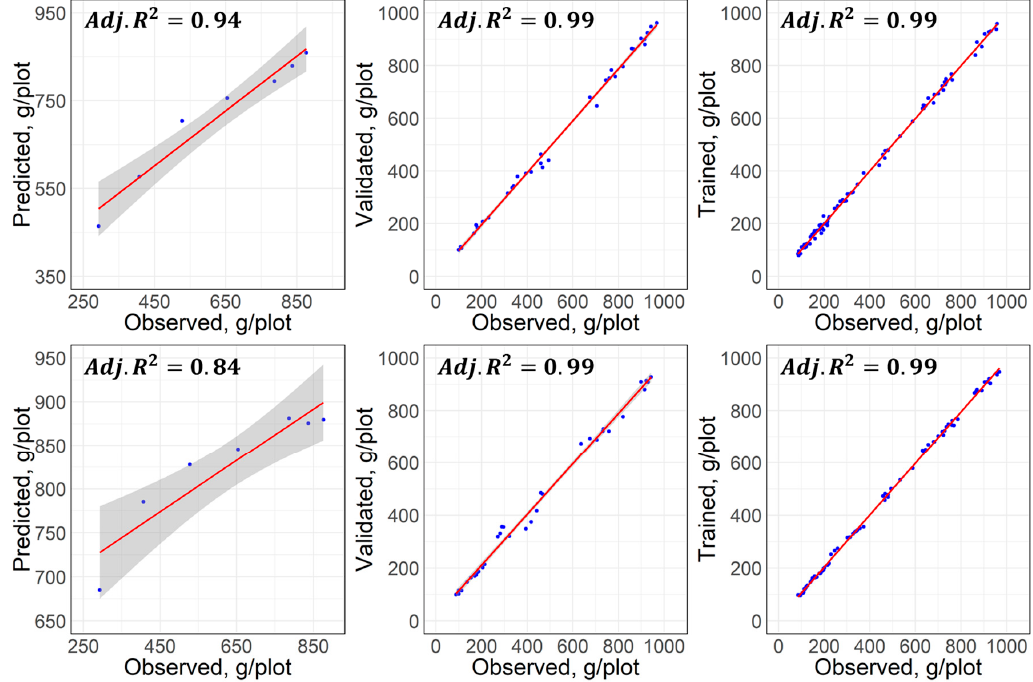
Figure 10. Scatter plots of the observed versus the modeled using the neural network, NN ( top ) entailing. ( Left ) Testing. ( Center ) Cross-validation. ( Right ) Training.